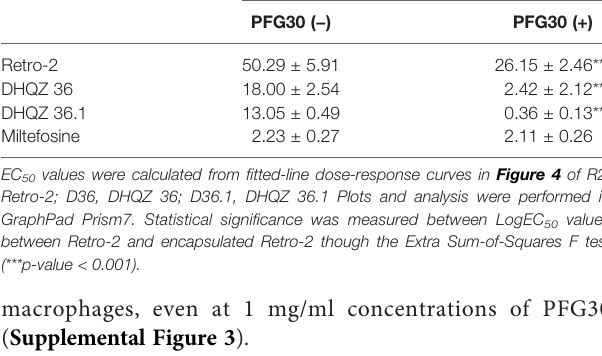
TABLE 2 | Estimated ef fi cacy on L. amazonensis infections of Retro-2 and DHQZ analogs with or without PFG30. Treatment